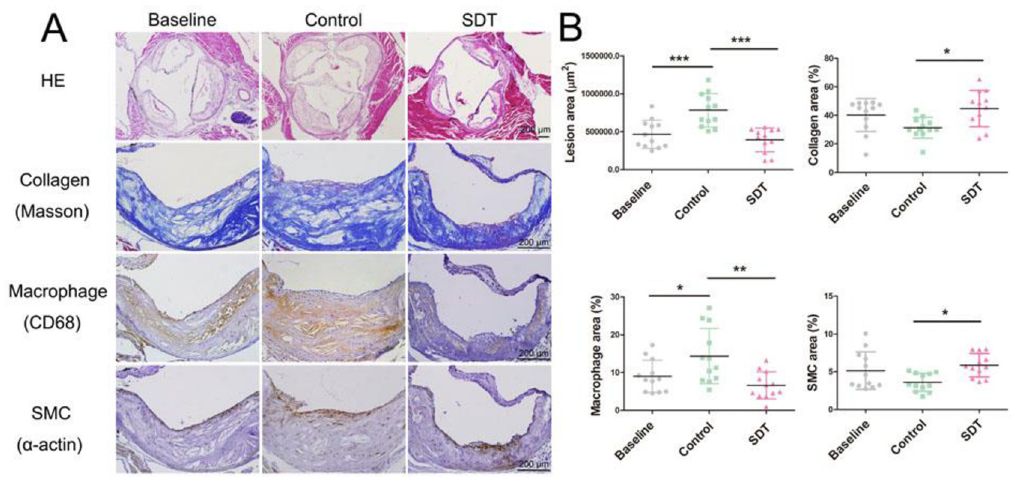
Fig 2. Sinoporphyrin sodium-mediated sonodynamic therapy (DVDMS-SDT) modifies the composition of and stabilizes ApoE-/- mouse advanced atherosclerotic plaque at 1 month after treatment. (A) Representative histopathological staining of consecutive plaque sections and (B) quantification (n = 12). � P < 0.05, �� P < 0.01, ��� P <